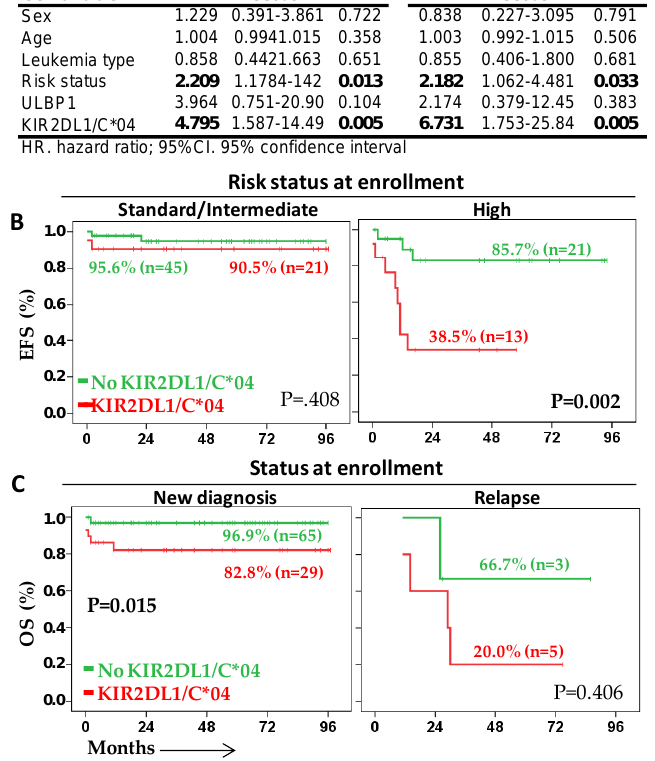
Figure 6. KIR2DL1/C*04 interaction is an independent prognostic biomarker. ( A ) Cox regression analysis for PFS and OS for sex, age, type of leukemia, risk status at enrollment, low/high expression of ULBP-1, and presence/absence of the KIR2DL1/C*04 interaction. ( B ) Kaplan–Meier and log-rank tests for EFS according to the presence/absence of KIR2DL1/HLA-C*04 interaction in standard/intermediate and high-risk patients. ( C ) Kaplan–Meier and log-rank tests for OS according to the presence/absence of KIR2DL1/HLA-C*04 interaction in patients enrolled because of new diagnosis or